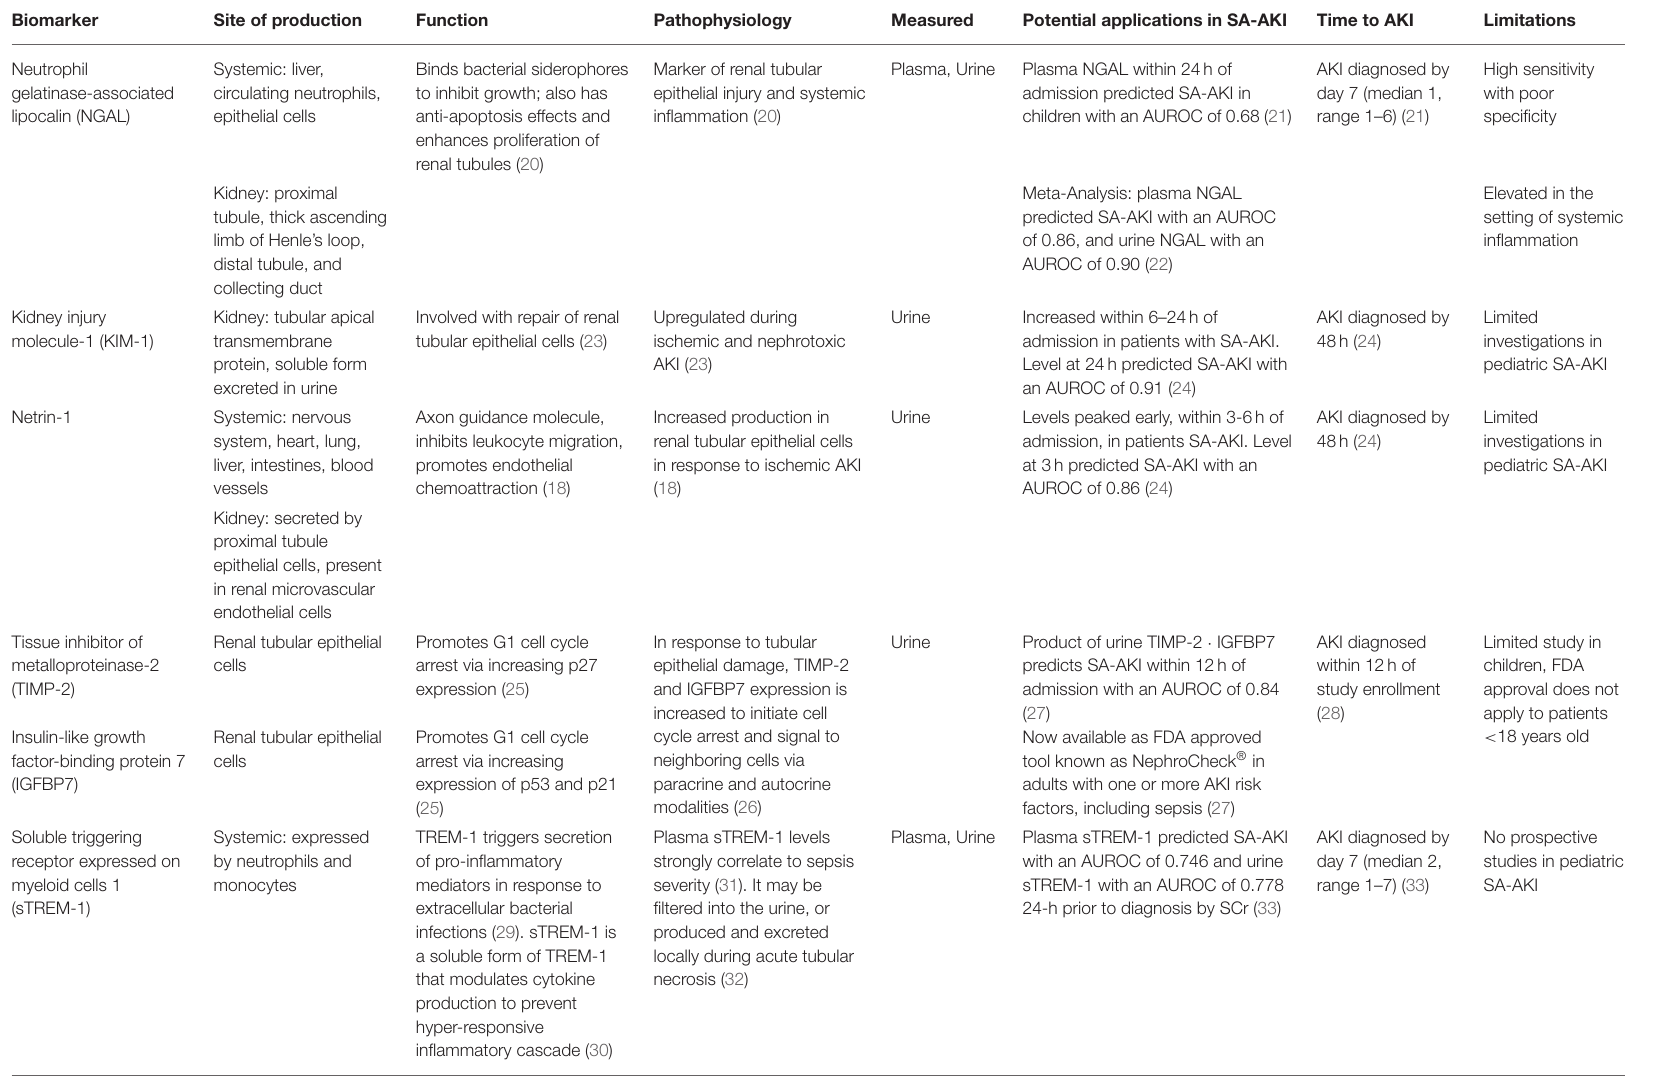
TABLE 1 | Investigated biomarkers of sepsis-associated acute kidney injury.